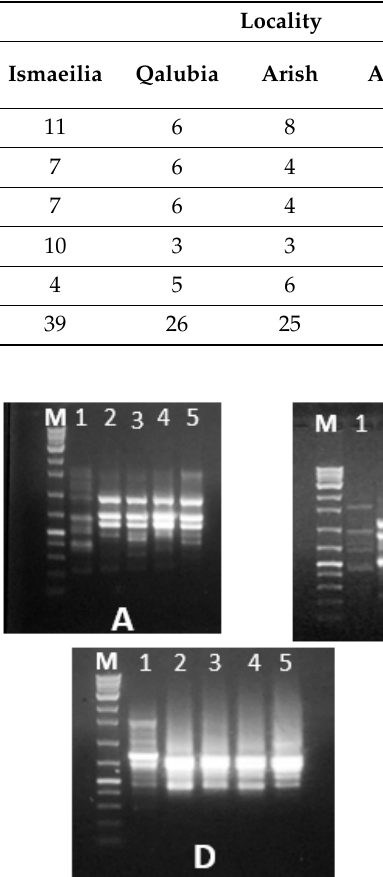
Table 3. RAPD primers, their nucleotide sequences and total number of bands for each locality produced by five primers.